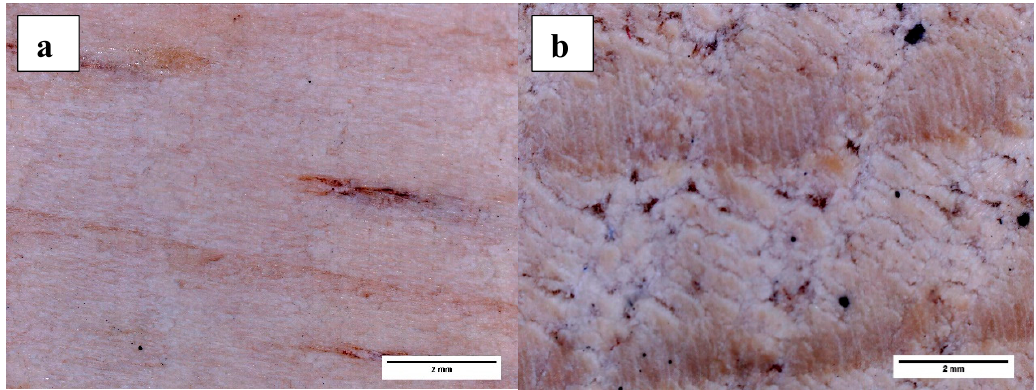
Figure 16. Macroscopic appearance of the samples: ( a ) longitudinal and ( b ) top view. Forests 2020 , 11 , x FOR PEER REVIEW